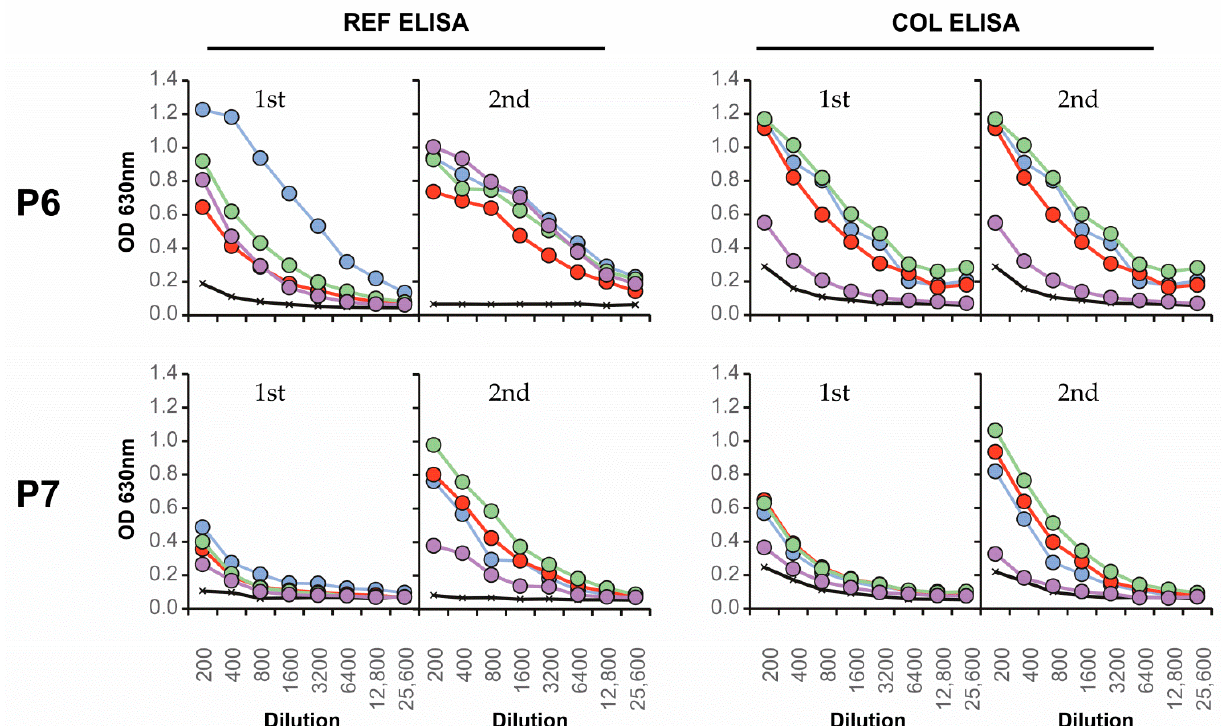
Figure 4. ED3-specific antibody detection by ED3 ELISA. Sera were collected from Colombian patients infected by DENV (P1–P7, Figure 1). Blue, ED3.1 (DENV-1); red, ED3.2 (DENV-2); green, ED3.3 (DENV-3); purple, ED3.4 (DENV-4). REF, antigens with ED3 sequences of a panel of reference strains. COL, antigens with ED3 sequences of Colombian strains. ED3 sequences and amino acid differences between REF and COL antigens are shown in Figure 2. Table 6. Serotype specificity of antibodies in Colombian second sera P1 −